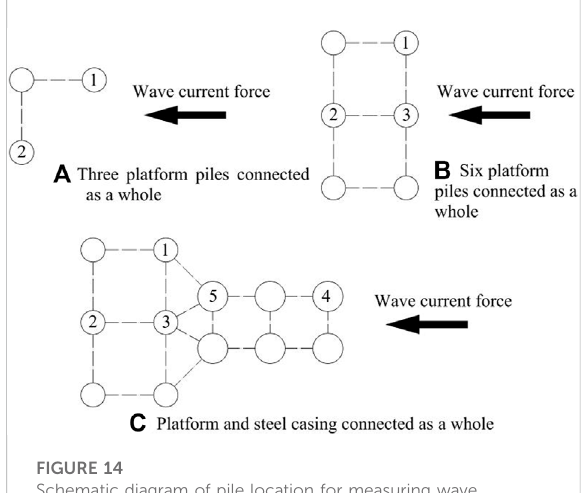
FIGURE 14 Schematic diagram of pile location for measuring wave current loads. (A) Three platforms piles connected as a whole. (B) Six platforms piles connected as a whole. (C) Platform and steel casing connected as a